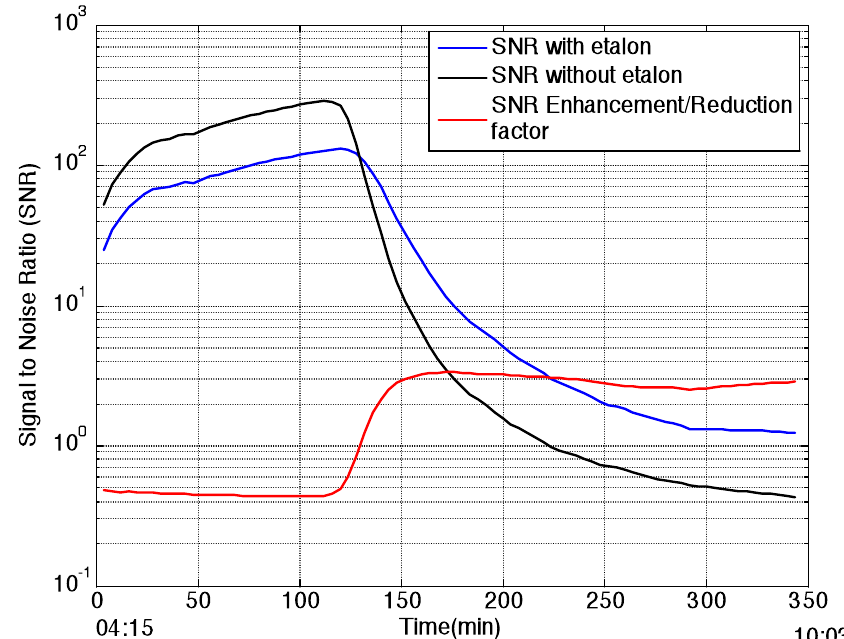
Figure 4. Lidar SNR values obtained at an altitude of 10 km on March 18, 2010. The times of the observations are given at the extreme ends of the plot, as local time. W is solar zenith angle.